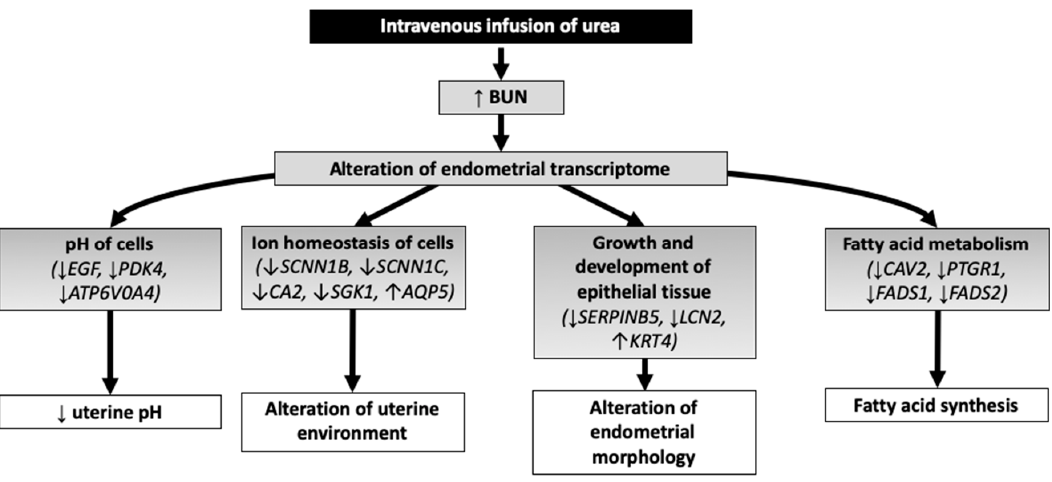
Figure 6. Schematic representation of proposed mechanisms of action of intravenous infusion of urea at day 7 of estrous cycle on the endometrium of mares over 6 hours. Supplementary Materials: The following are available online at www.mdpi.com/xxx/s1. Table S1: Forward and reverse primers used for quantitative Real-Time PCR analysis. Table S2: List of the most up- and down-differently expressed genes in the endometrium of mares from the urea compared to the control group in a crossover design. Table S3: List of genes identified in modules with a significant relationship with the traits analyzed.